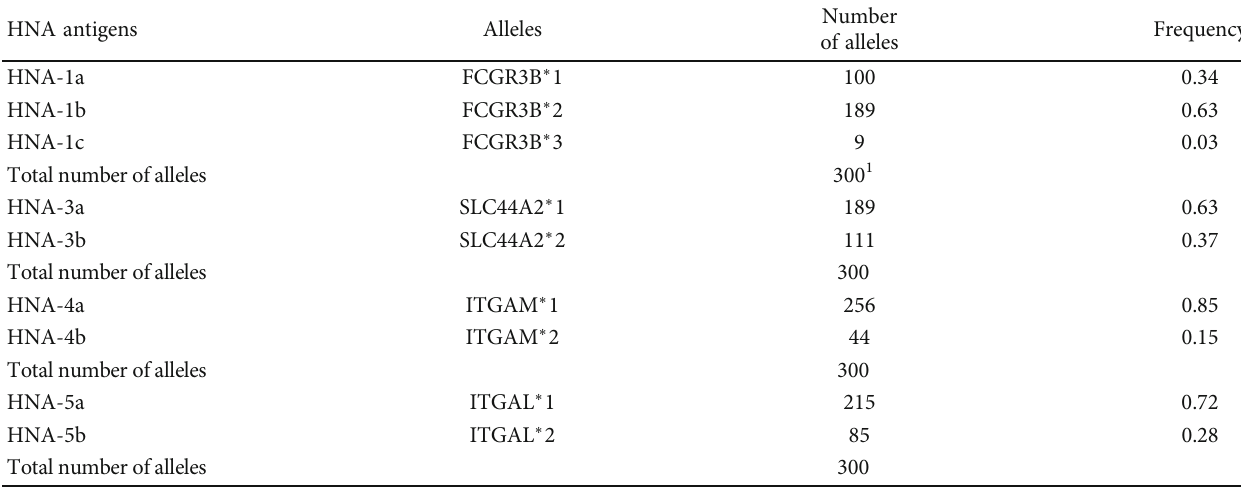
Table 3: Allele frequency of HNAs in Iranian blood donors.